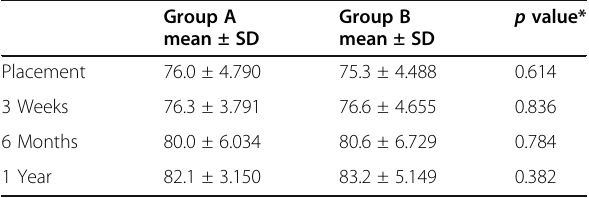
Table 4 Mean ISQ values at different time points